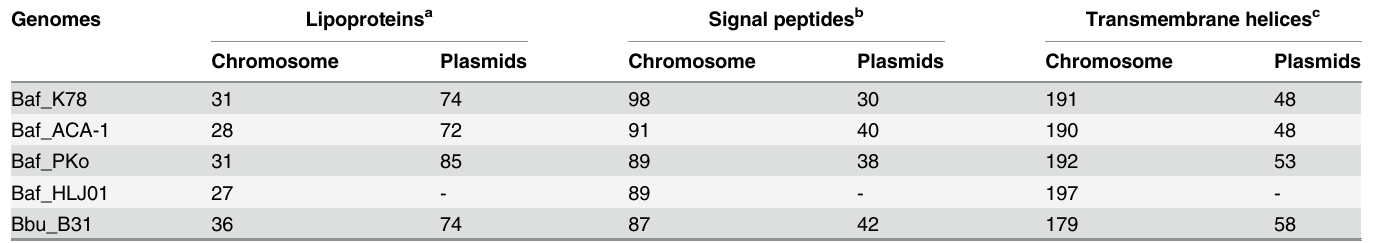
a Lipoprotein predictions (SpLip). Given counts are “ probable ” and “ possible ” hits combined. b Signal peptide prediction (SignalP) were not counted when SpLip predicted a lipidation signal for the protein.